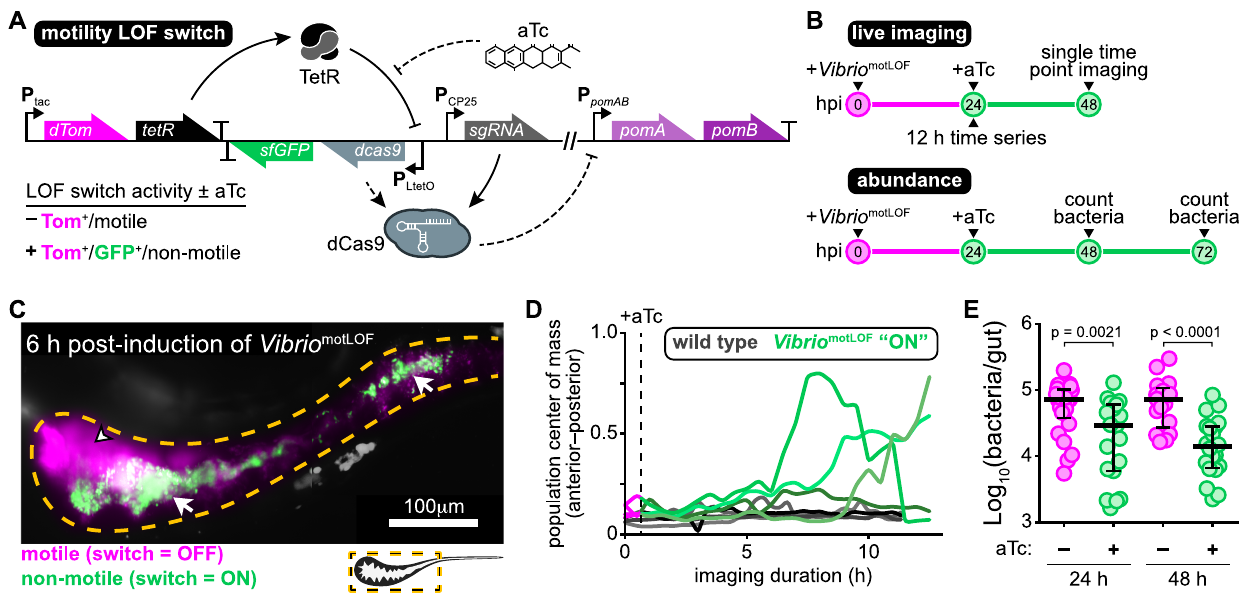
Fig 4. Sustained swimming motility is required for maintaining intestinal spatial organization and persistence. (A) Schematic of CRISPRi-based motility LOF switch. Lower left table summarizes switch activity and bacterial behaviors +/ − aTc. Bent arrows denote promoters; “T” denotes transcriptional terminators. Solid lines represent constitutive interactions; dashed lines represent induced interactions. (B) Experimental timelines used to investigate in situ inactivation of swimming motility. (C) A maximum intensity projection acquired by LSFM of an animal colonized by Vibrio motLOF at 6 hpi. Dashed line marks approximate intestinal boundaries. An arrowhead with a black stroke marks an area of swimming cells expressing only dTomato (magenta, “switch = OFF”). White tailed arrowheads mark aggregated cells (green, “switch = ON”). (D) Population center of mass over time for intestinal populations of wild-type Vibrio (gray) and Vibrio motLOF (magenta/green). Lines are single bacterial populations within individual fish. Vertical dashed line marks time of aTc induction. (E) Abundances of Vibrio motLOF at 24 and 48 hpi with aTc. Bars denote medians and interquartile ranges. Significant differences determined by Mann-Whitney. Underlying data plotted in panels D and E are provided in S1 Data. aTc, anhydrotetracycline; CRISPRi, CRISPR interference; hpi, hours post induction; LOF, loss-of-function; LSFM, light sheet fluorescence microscopy.